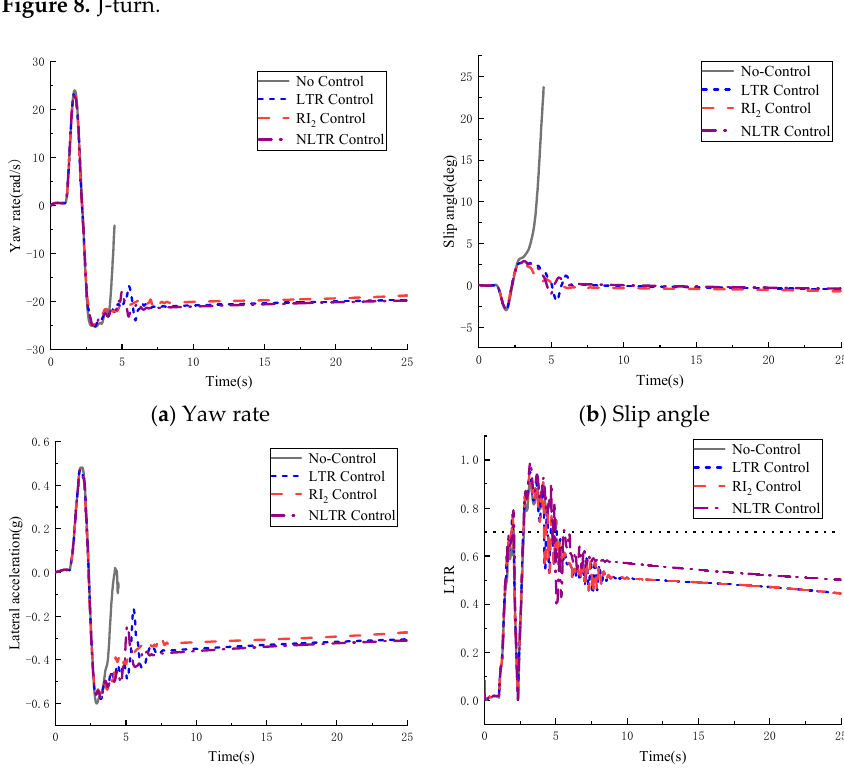
Figure 9. Fishhook. Figure 9.